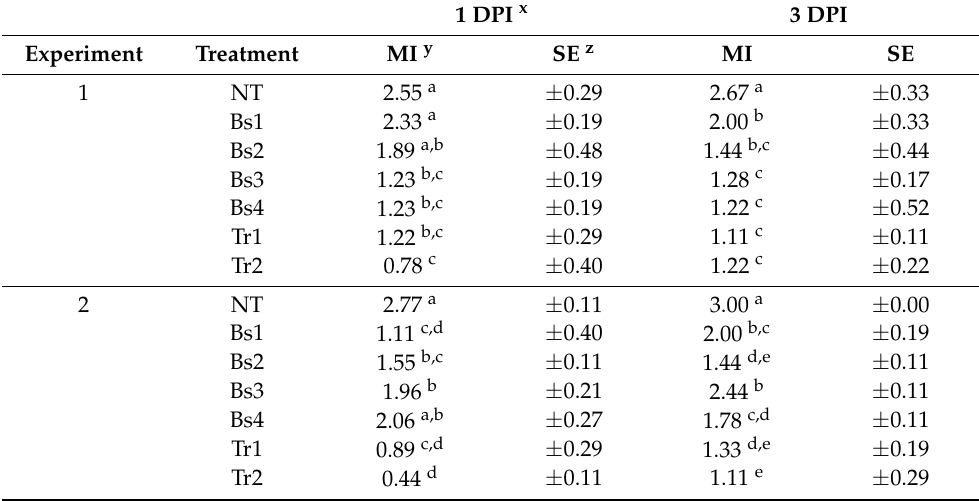
Table 2. Effect of curative applications of biological control agents (BCAs) on Stemphylium vesicarium mycelial growth. BCAs used were Bacillus subtilis strains (Bs1, Bs2, Bs3, Bs4) and Trichoderma spp. strains (Tr1, Tr2) applied 1 or 3 days post-inoculation. NT: non-treated control. Means with the same letter in each experiment are not significantly different according to Fisher’s protected least significant difference test ( p < 0.01). 1 DPI x 3 DPI Experiment Treatment MI y SE z NT